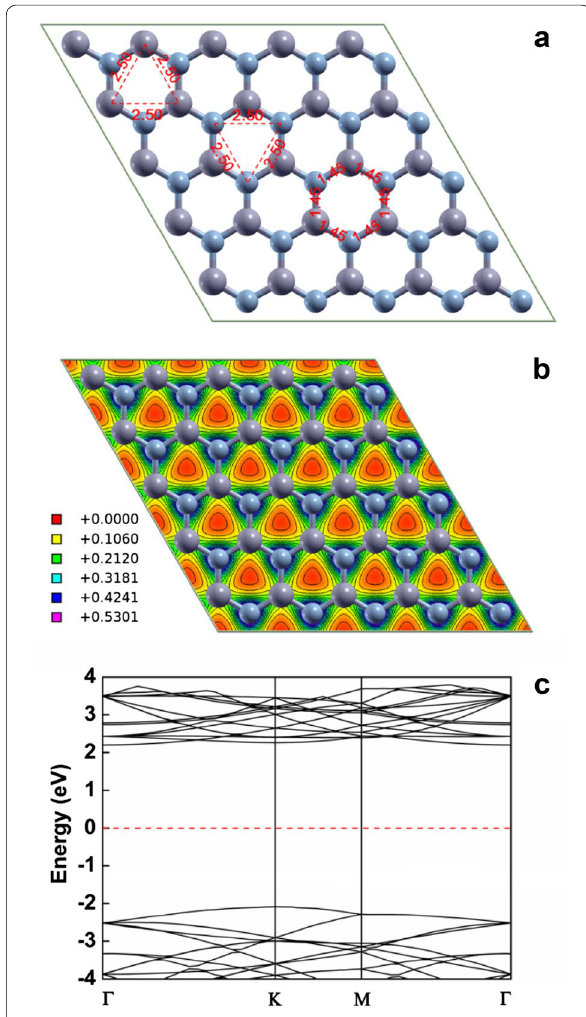
Fig. 2 a Relaxed structure, b isodensity plot, and c electronic band structure of pristine h‑BN. The Fermi level is set to be